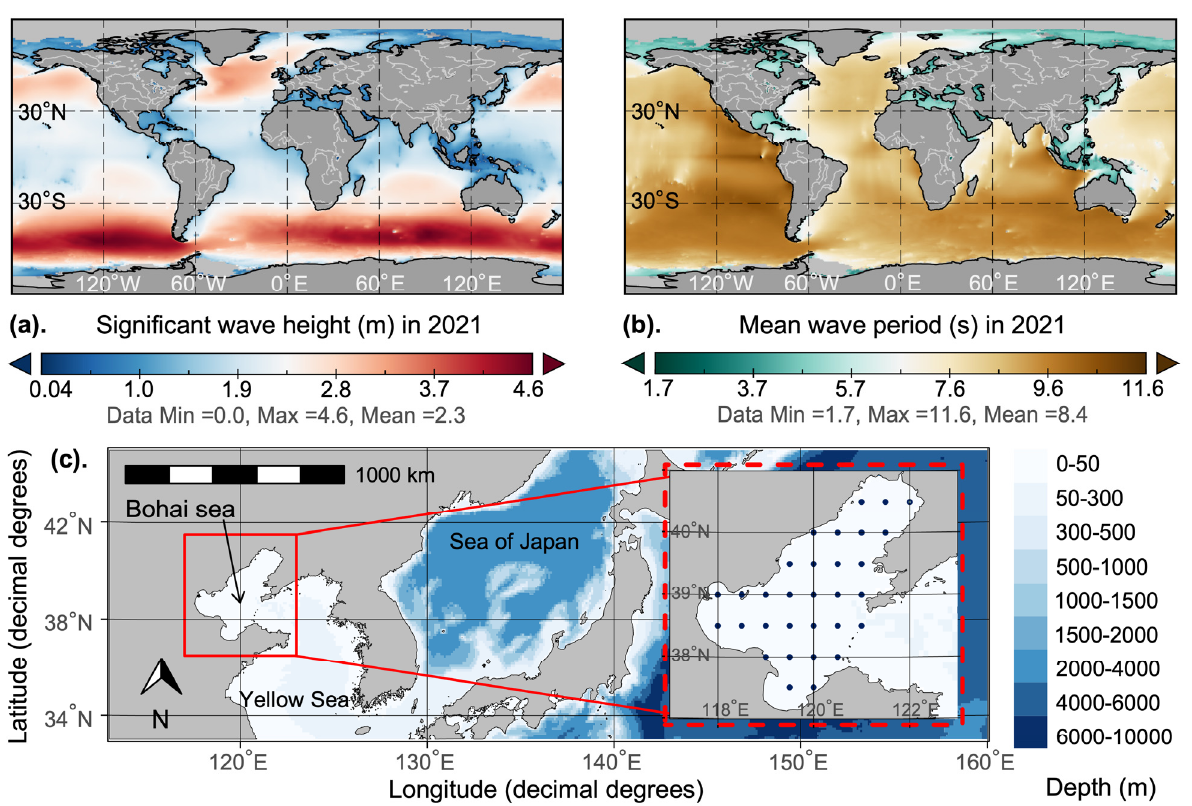
Figure 3. Annual averages of significant wave height ( a ) and mean wave period ( b ) in 2021, both globally and in the study area, with 31 research coordinates in the Bohai Sea ( c ).